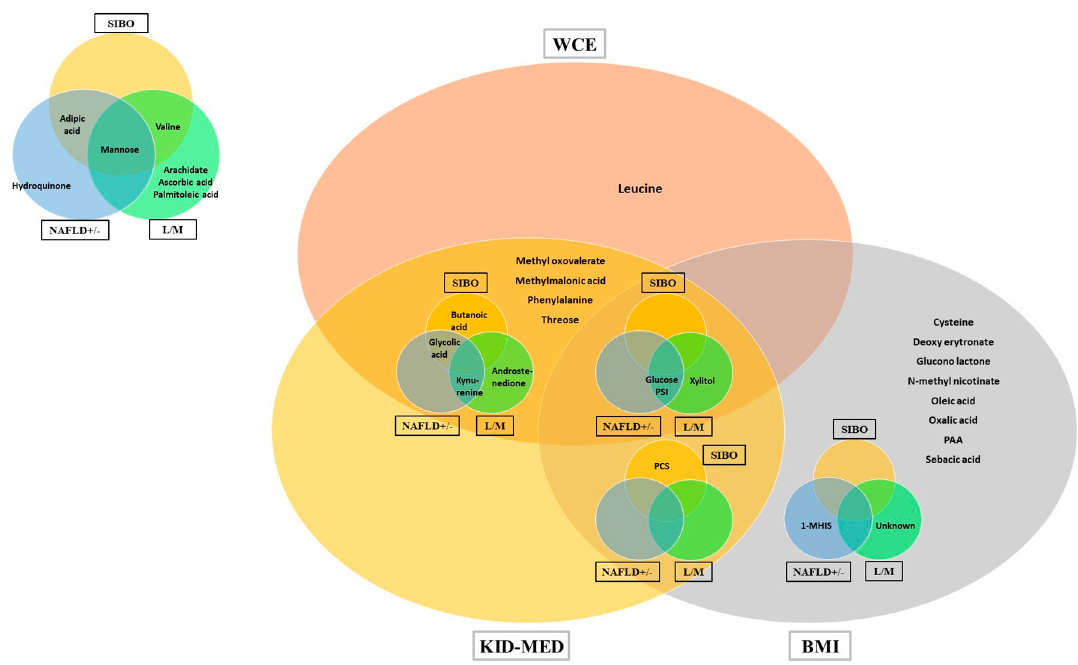
Figure 4. Venn diagram of the selected metabolites. Metabolites selected in the discriminant analysis (BMI, NAFLD and SIBO) and in the multivariate linear regression (WCE, L/M and KidMed). In the circle and oval overlaps, we represent the metabolites selected as VIP in more than one model. Only Glucose and pseudouridine (PSI) were common to all six models. Abbreviations: BMI (Body Mass Index), L/M (Lactulose to Mannitol ratio), (PSI) Pseudouridine, SIBO (Small Intestine Bacterial Overweight), WCE (centimeters exceeding 90th percentile of Waist Circumference), NAFLD (non-alcoholic fatty liver disease).